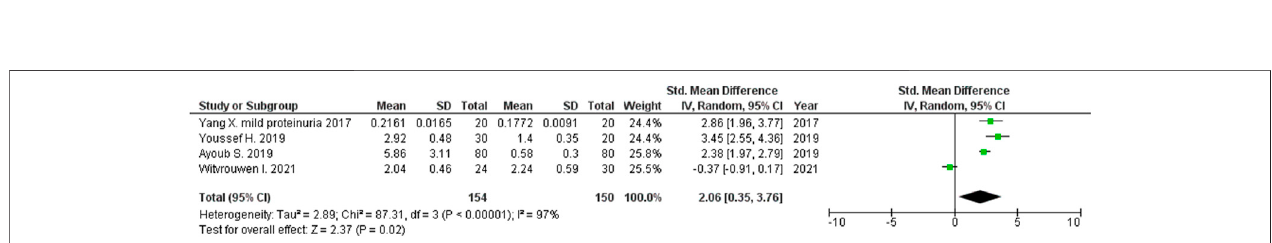
FIGURE 9 | Meta-analysis of differences in expression level of miRNA-155 in peripheral blood between women with vs. without preeclampsia.